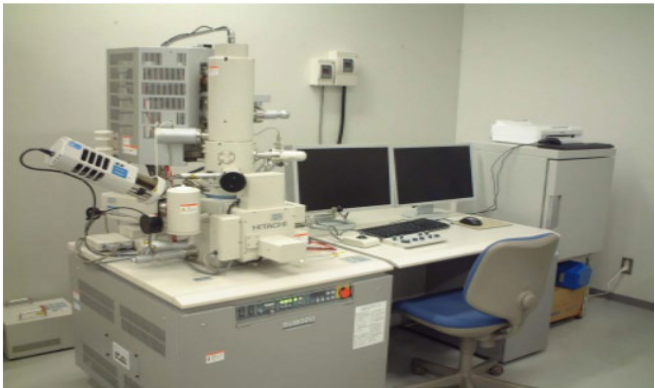
Figure 13. SU8020 emission sweep electron microscope.